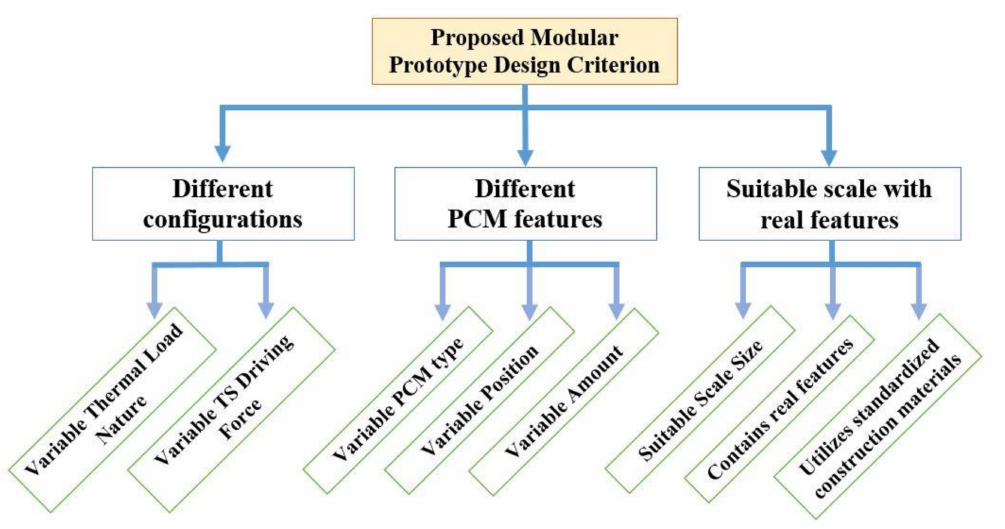
Figure 14. Summary of the goals and their details corresponding to the criterion followed in the